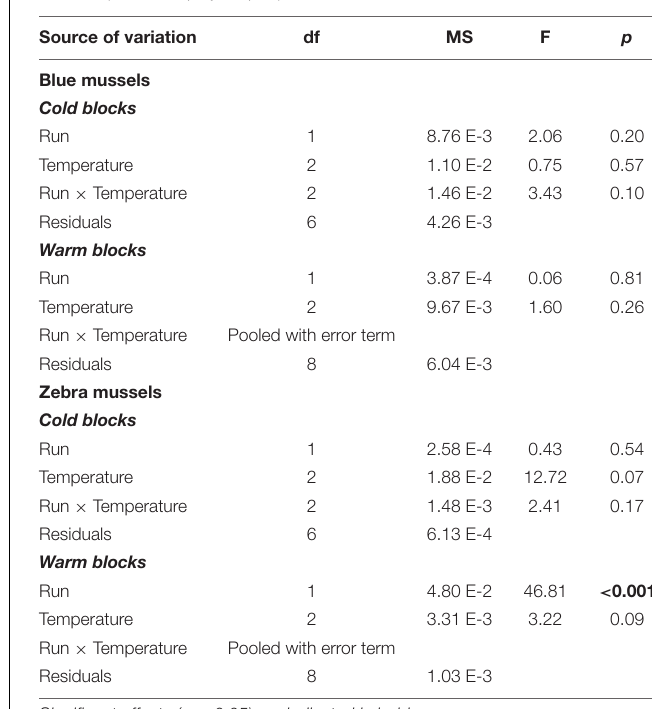
TABLE 1 | Results of two-way factorial ANOVAs evaluating the effect of temperature on the filtration activity of blue mussels ( Mytilus edulis ) and zebra mussels ( Dreissena polymorpha ) in the control